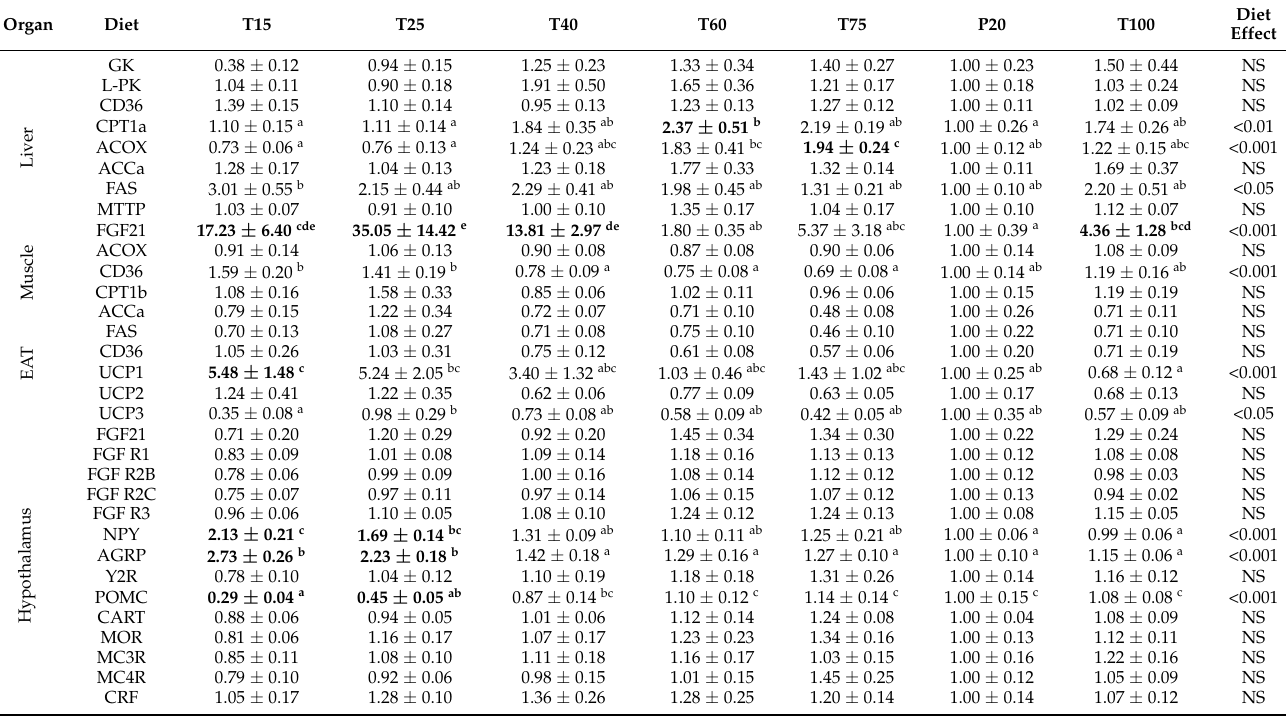
Table 6. Absolute relative expression of mRNA as determined by RT-qPCR for threonine